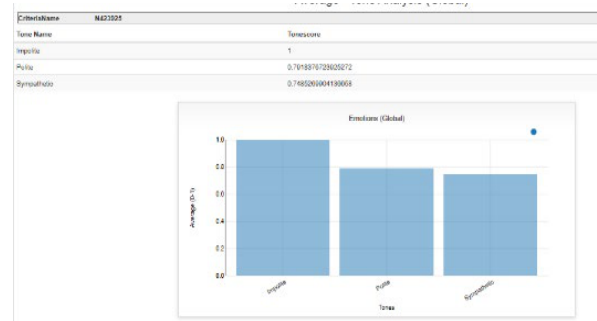
Figure 25. Volunteer Tones per Conversation